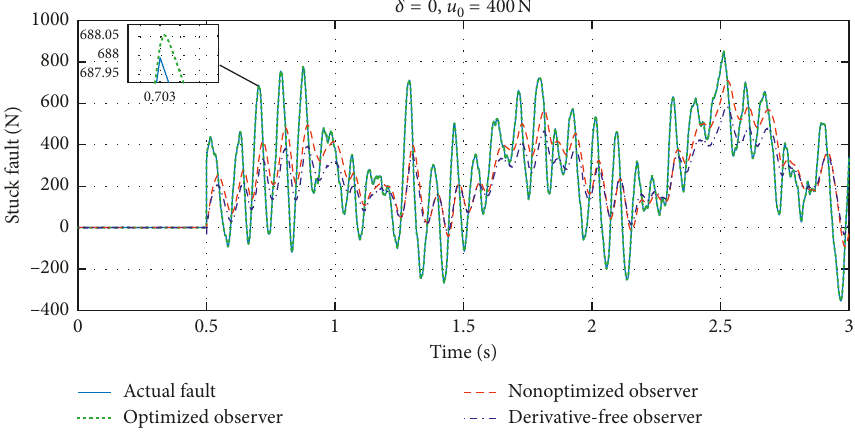
Figure 4: Tracking effects of the stuck fault ( random road ).